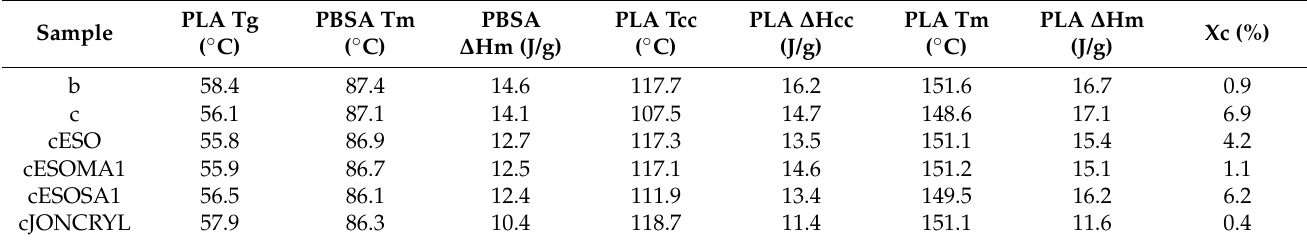
Table 6. Thermal features derived from DSC analysis of b, c, cESO, cESOMA1, cESOSA1, and cJONCRYL. Sample